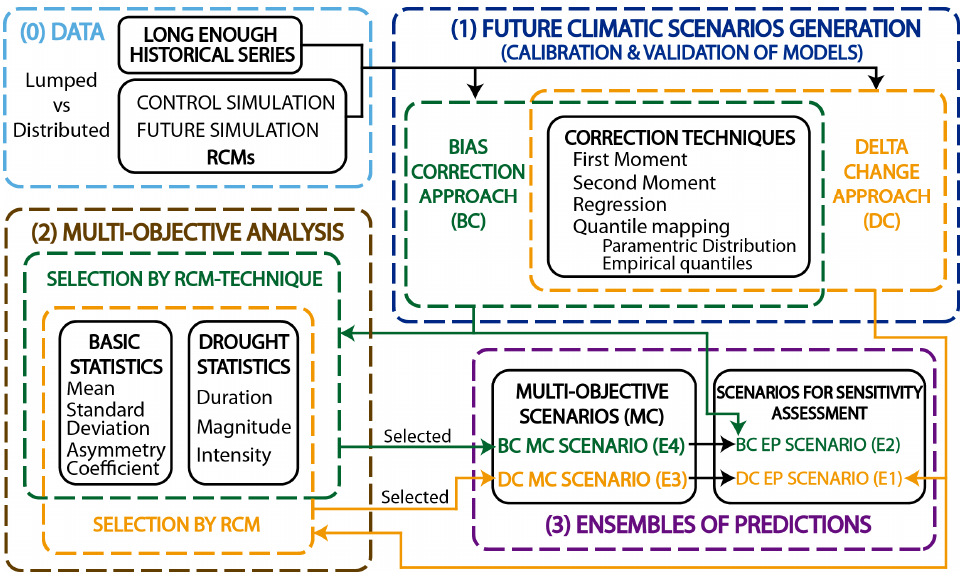
Figure 1. Flow chart of the proposed methodology.